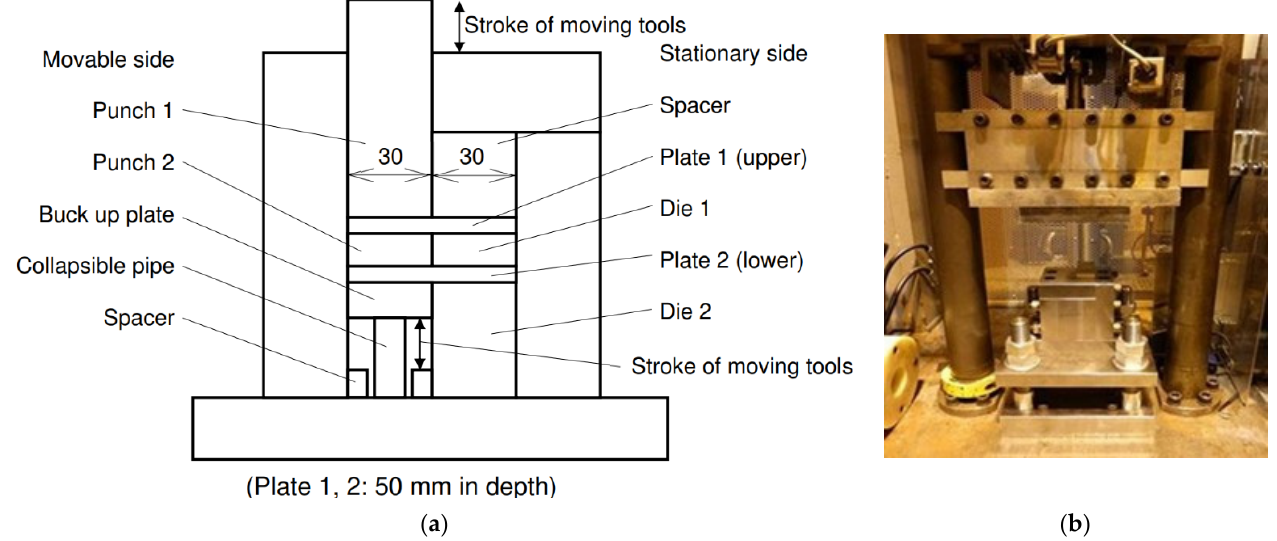
Figure 2. Impact joining device: ( a ) Cross-sectional schematic; ( b ) General view and drop weight.